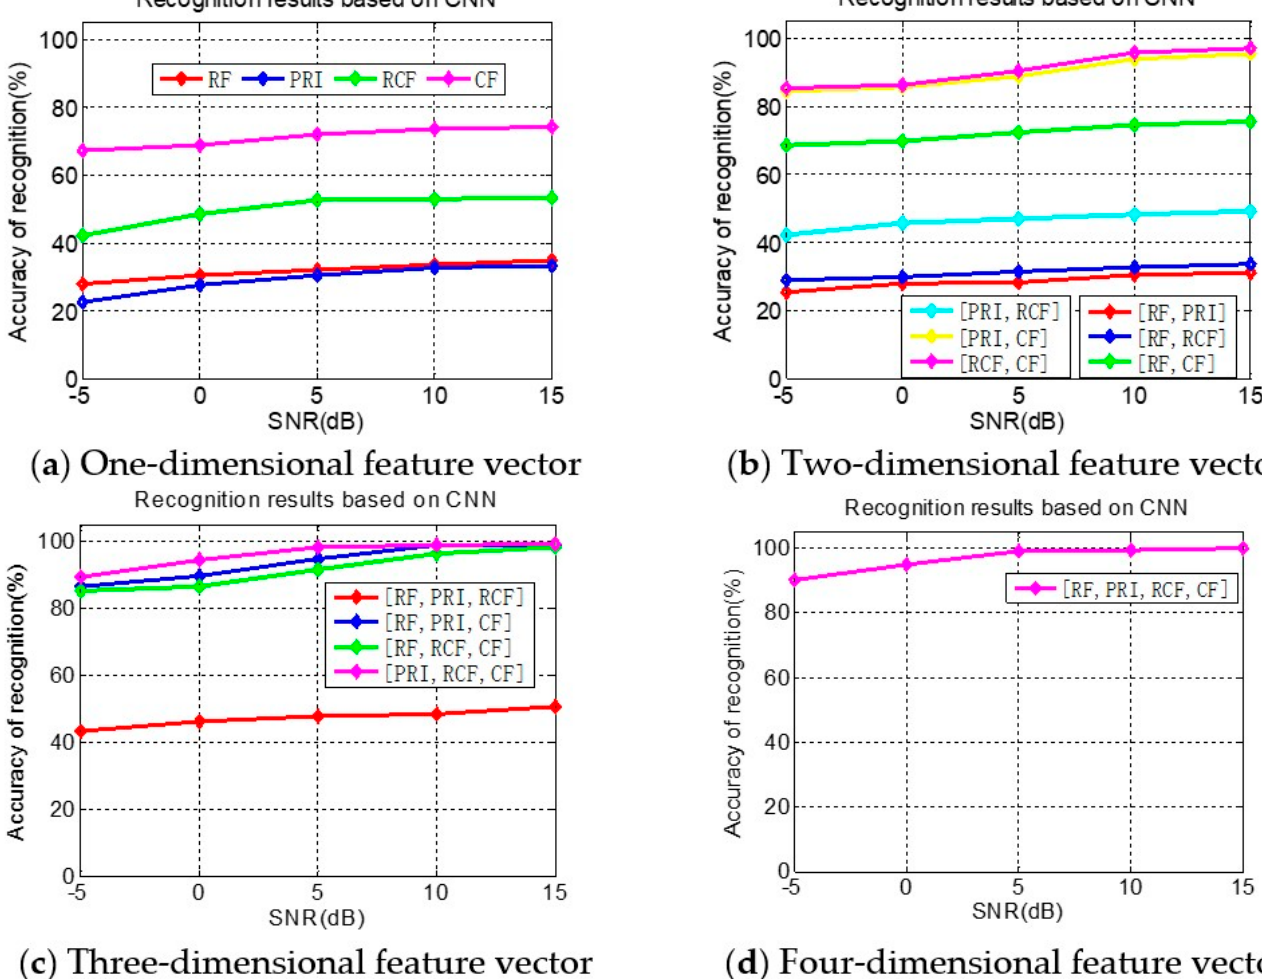
Figure 3. Recognition results by CNN in different SNRs.